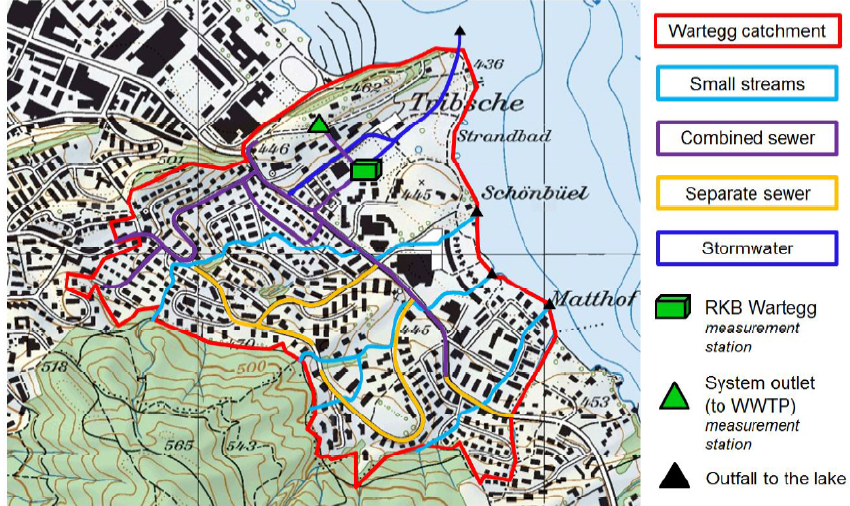
Figure 2. Case study catchment area situated in